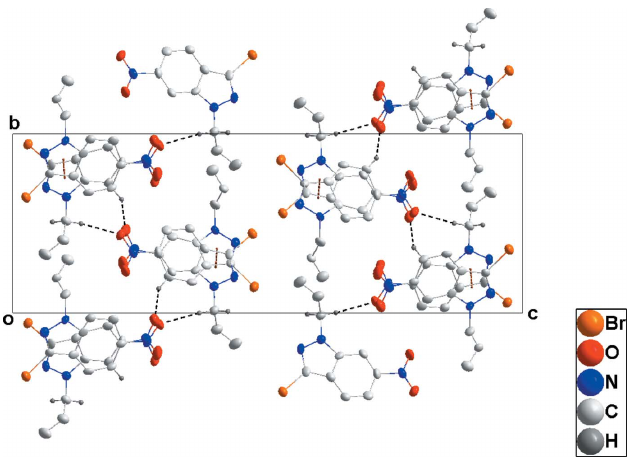
Figure 4 Packing viewed along the b -axis direction with intermolecular inter- actions shown as in Fig. 2